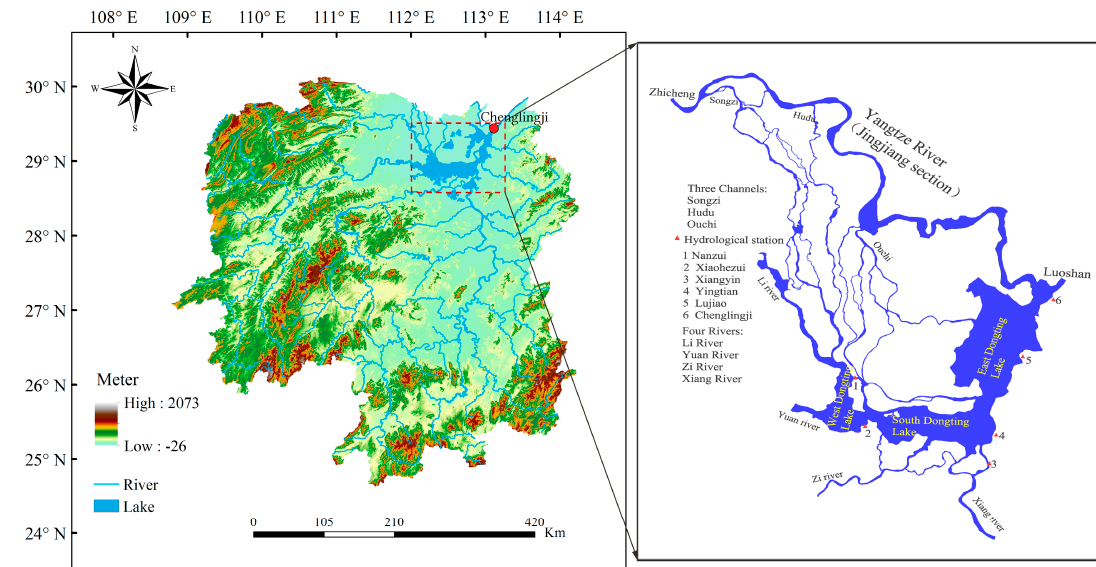
Figure 2. Location of Dongting Lake. The lake collects water from the Yangtze River through ‘three channels’ (Songzikou, Taipingkou, and Ouchikou) and ‘four rivers’ (Xiang, Zi, Yuan, and Li) and it discharges to the Yangtze River at Chenglingji.